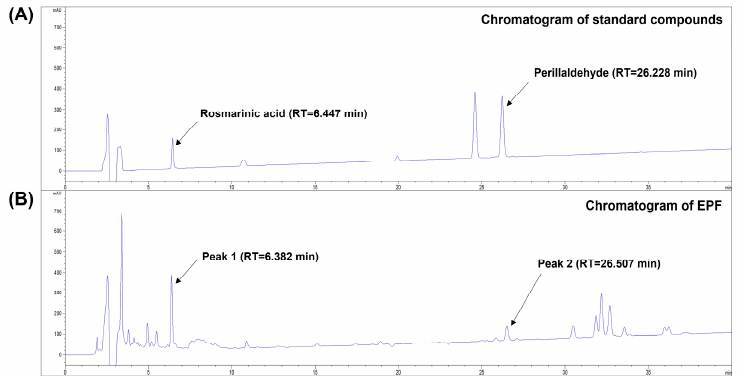
Figure 2. HPLC analyses of standard compounds and EPF. Total HPLC chromatograms of rosmarinic acid, perillaldehyde ( A ), and EPF ( B ) were obtained at a UV wavelength of 233 nm. EPF, ethanol extract of Perilla frutescens leaves; HPLC, high-performance liquid chromatography; RT, retention time.